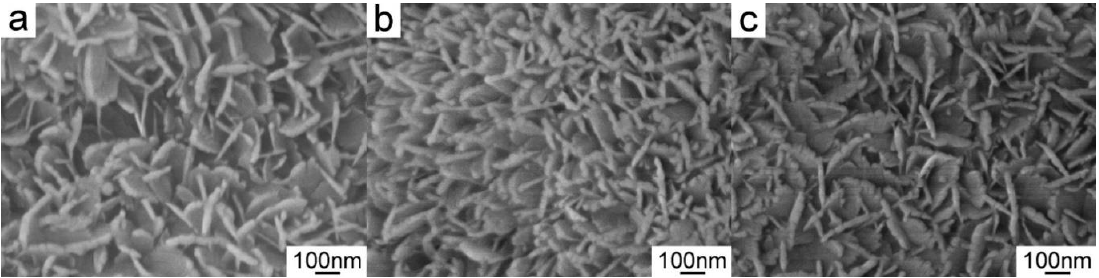
Figure 5. SEM images of ( a ) A17H6, ( b ) A27H6, and ( c ) A37H6.